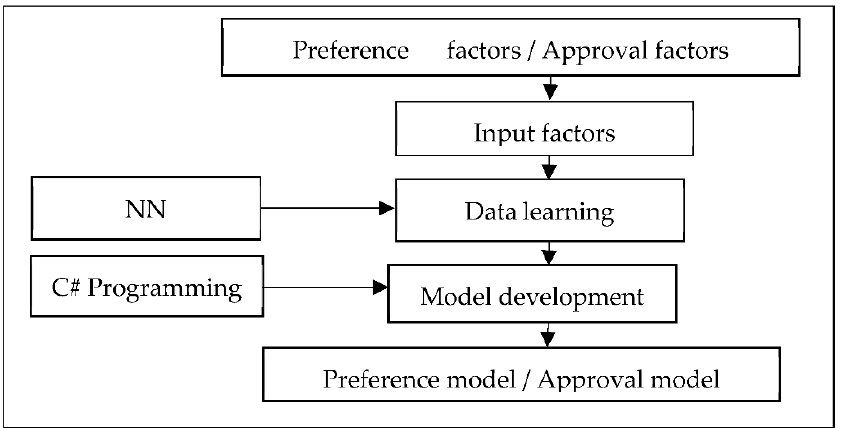
Figure 3. Preference model and approval model development .